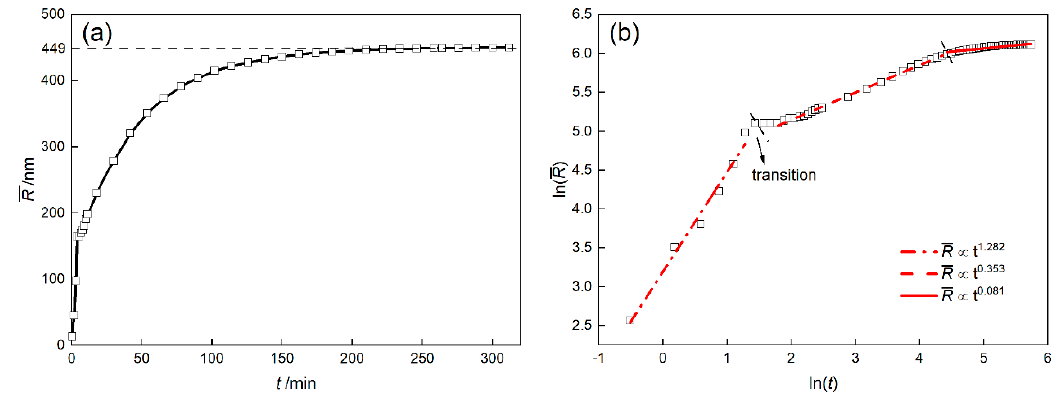
(cid:16) (cid:17) ∼ ln ( t ) ( b ) of DD6 superalloy R